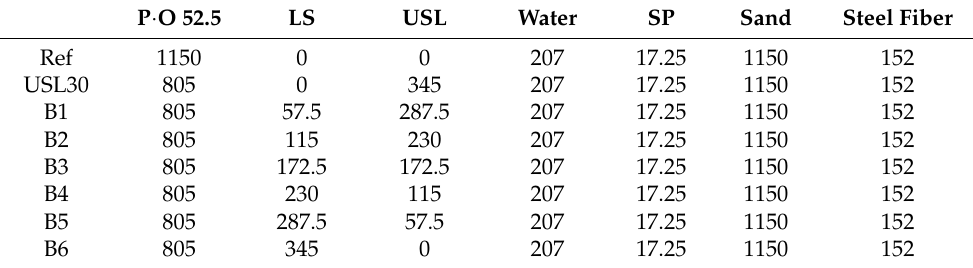
Table 2. Mixture proportioning the UHPC mixtures (kg/m 3 ).